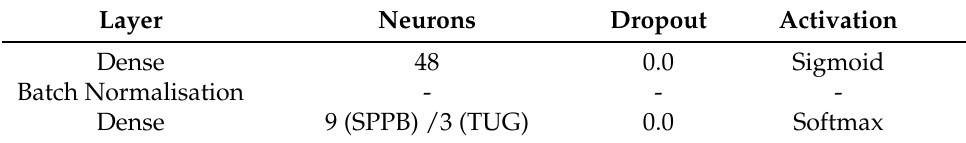
Table A6. The layer details of Block